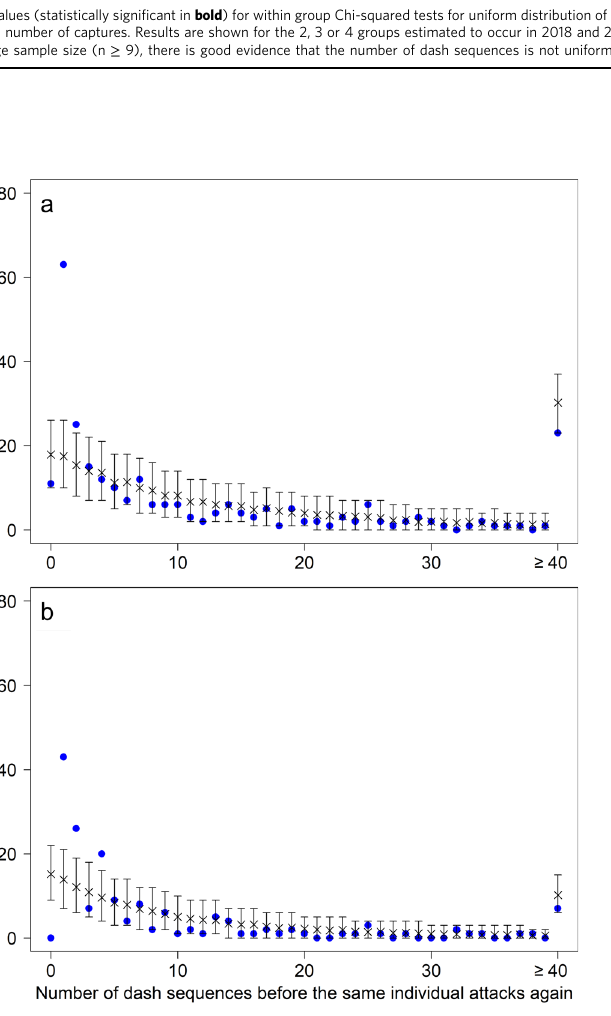
Fig. 4 Numbers of dash sequences between two attacks of the same marlin. Observed ( ) and expected (x) numbers of dash sequences of other marlin between two dash sequences of the same marlin in 2018 ( a ) and 2019 ( b ). Additionally, 2.5th and 97.5th percentiles for each point are shown (simulating 10 4 repetitions). The outliers at x-axis value of 1 in both a and b show the occurrences of ABA dash sequences, i.e., where an individual marlin A, returns to attack immediately after any other marlin B ’ s single dash sequence. The fi nal data point lies higher as it shows the data for the value 40 and